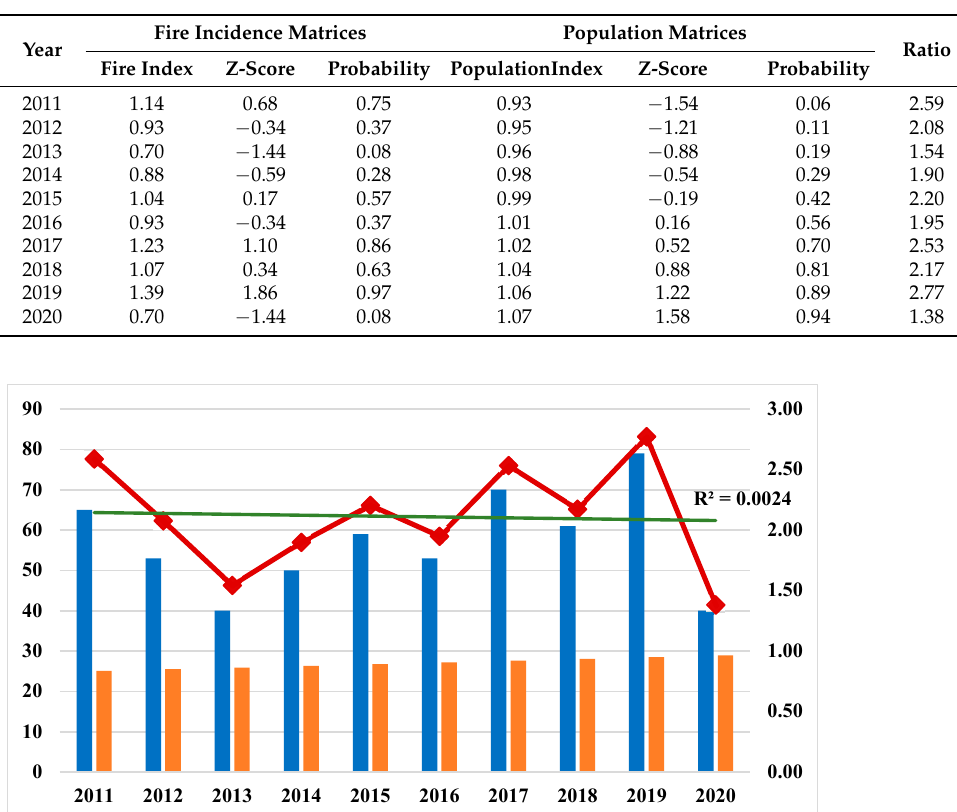
Table 7. Fire incidences and population matrices.